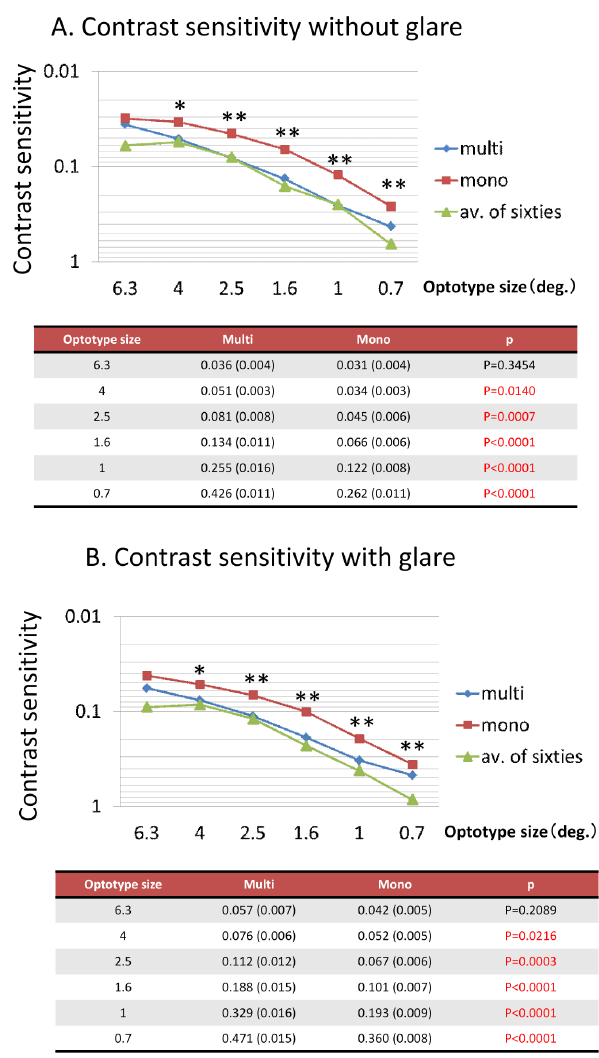
Figure 2. Postoperative contrast sensitivity with and without glare. The average value for 60-year-old normal subjects is cited from a report by Takahashi [29]. measured these parameters twice within two months before cataract surgery, then took the mean of these two measurements and used the average of the right eye and left eye means. The quality of vision was evaluated using the Japanese version of the 25-item National Eye Institute Visual Function Questionnaire (NEI VFQ-25) [23]. The NEI VFQ-25 was administered by experienced technicians or nurses in a face-to-face setting. Uncorrected distance visual acuity (UDVA) and corrected distance visual acuity (CDVA) were measured at 5.0 m. Uncor- rected intermediate visual acuity (UIVA) and corrected interme- diate visual acuity (CIVA) were measured at 0.5 m. Uncorrected near visual acuity (UNVA) and corrected near visual acuity (CNVA) were measured at 0.3 m. Visual acuity was measured using the decimal visual acuity chart, and the measured decimal values were converted to the logarithm of the minimum angle of resolution (logMAR) scale. The radius of corneal curvature, corneal astigmatism and refractive status were measured using a KR-8900 autorefractor keratometer (Topcon, Tokyo, Japan).